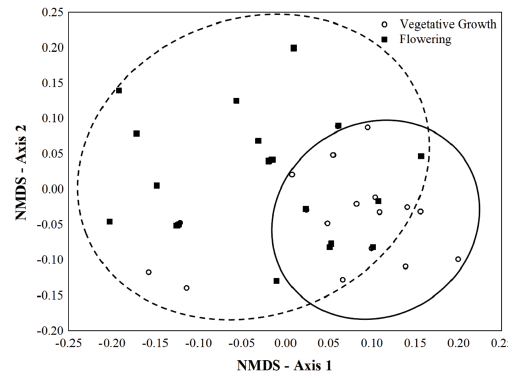
Figure 3. Non-metric multi-dimensional scaling (NMDS) ordination for phenological phases (vegetative growth and flowering), based on composition of insect larvae associated with A. distichantha in rocky walls.